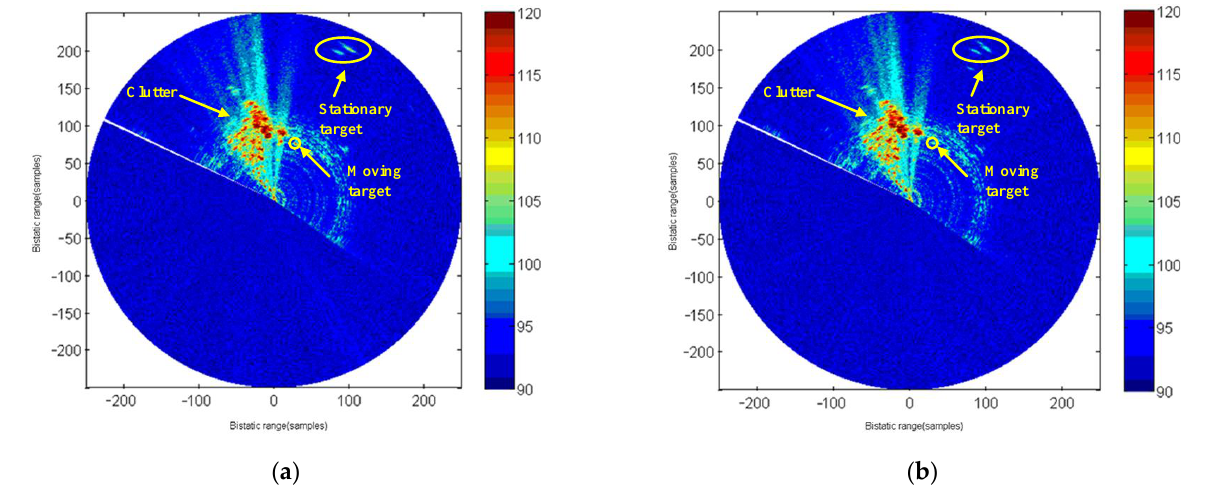
Figure 24. HBR map for maritime moving target detection: ( a ) Third circle; ( b ) Fourth circle. Figure 25a,b are HBR maps after the mean clutter map (ME-CM) cancellation and single pole feedback clutter map (SPFB-CM) cancellation processing, respectively.